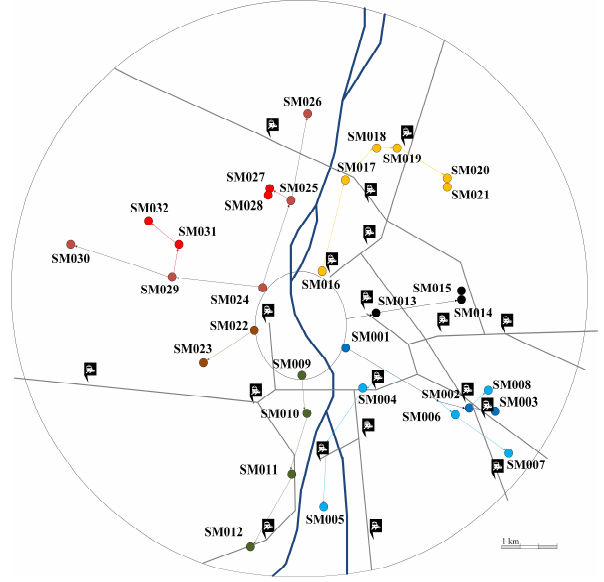
Figure 16. The geometrical model of Budapest, with railway and waterway connections.